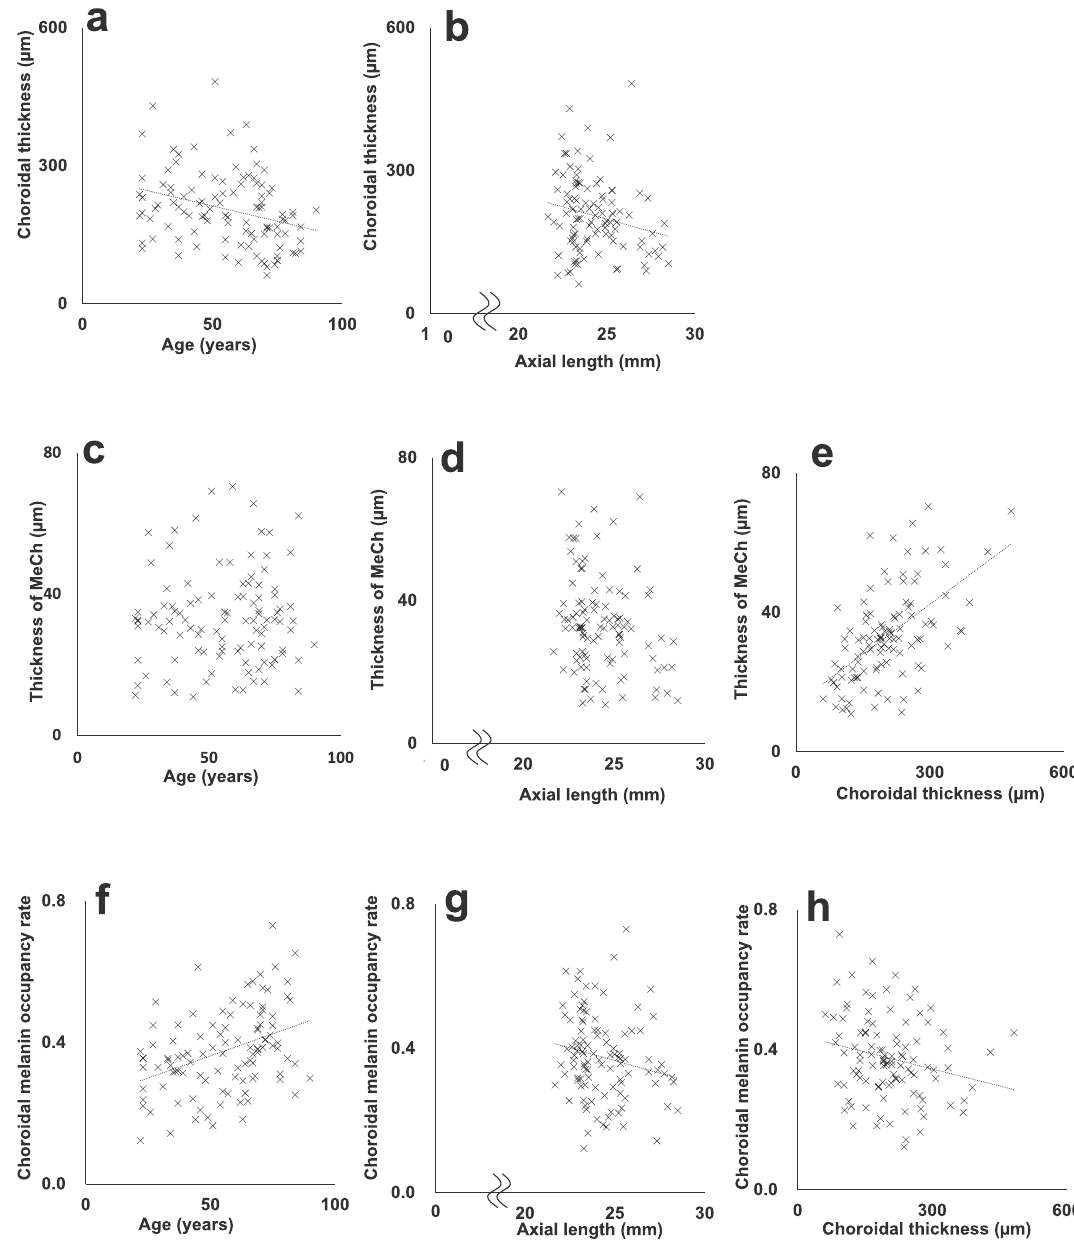
Figure 3. Scatterplots of choroidal thickness as a function of ( a ) age and ( b ) axial length. Scatterplots of thickness of melanin-containing tissue in the choroid (thickness of MeCh) as a function of ( c ) age, ( d ) axial length, and ( e ) choroidal thickness. Scatterplots of choroidal melanin occupancy rate as a function of ( f ) age, ( g ) axial length, and ( h ) choroidal thickness. Dotted lines indicated the regression lines of relationships with significant